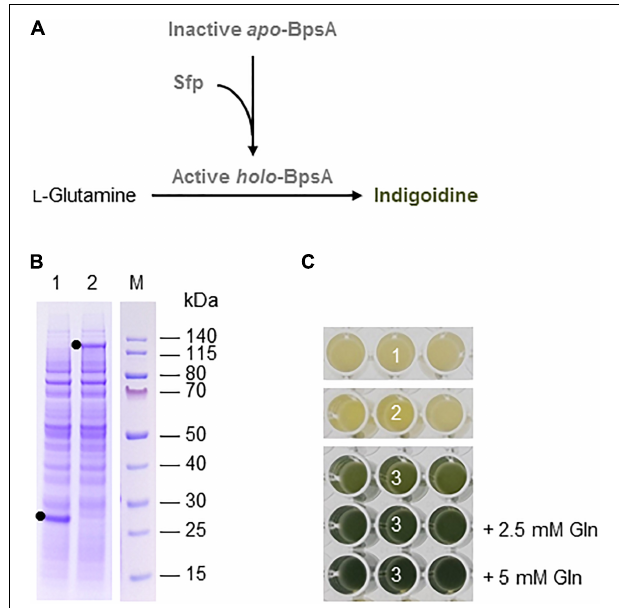
FIGURE 2 | Indigoidine biosynthesis in the BY-2 cell-free system. (A) Schematic overview of the engineered indigoidine biosynthesis pathway. The inactive apo -form of blue pigment synthetase A (BpsA) from S. lavendulae is activated by the 4 (cid:48) -phosphopantetheinyl transferase Sfp from B. subtilis in a reaction requiring coenzyme A. The active holo -form of BpsA then catalyzes the conversion of two L -glutamine molecules to indigoidine. (B) SDS-PAGE analysis of BYL transcription–translation reactions after incubation for 44 h at 25 ◦ C and 70% humidity, shaking at 500 rpm. In each case, 0.5 µ L of the reaction mix was loaded onto a 4–12% (w/v) gradient gel. Lane 1: Sfp (26 kDa), lane 2: BpsA (141 kDa). (C) Image of the in vitro reactions after incubation for 18 h: (1) Sfp, (2) BpsA, and (3) Sfp + BpsA. Reactions were supplemented with L -glutamine (Gln) as